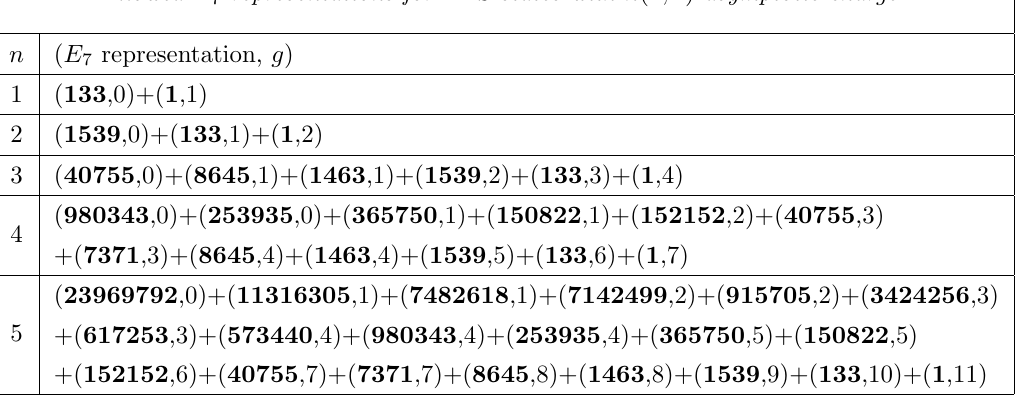
Table 4 . The allowed representations for BPS states with asymptotic charges n (1 ; 1), with 1 (cid:20) n (cid:20) 5 are listed. We also keep track of the genus of the corresponding holomorphic curves. As discussed in the text, only real representations